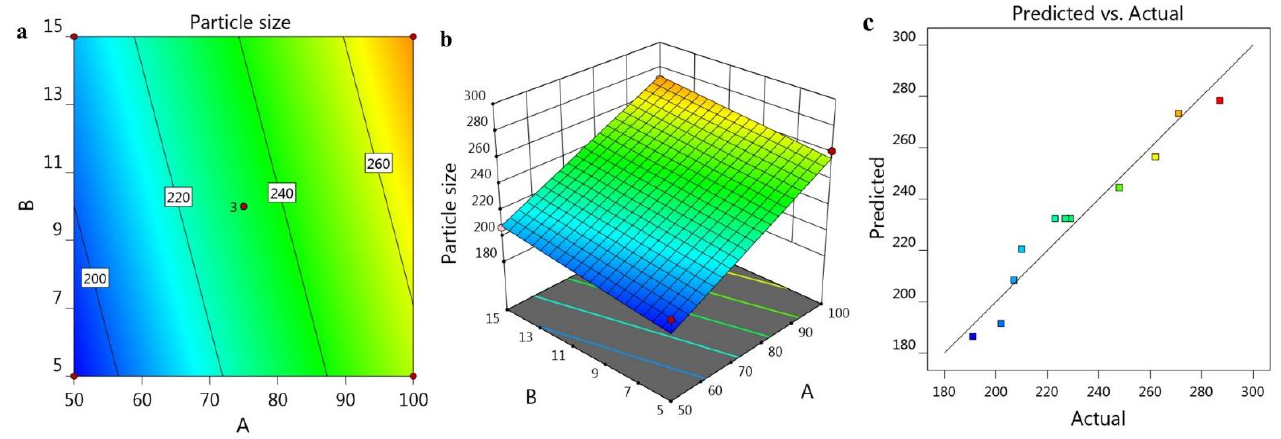
Figure 1. Representing ( a ) 2D-Contour plot, ( b ) 3D-Response Surface Plot, and ( c ) linear correlation plot between predicted against actual values.